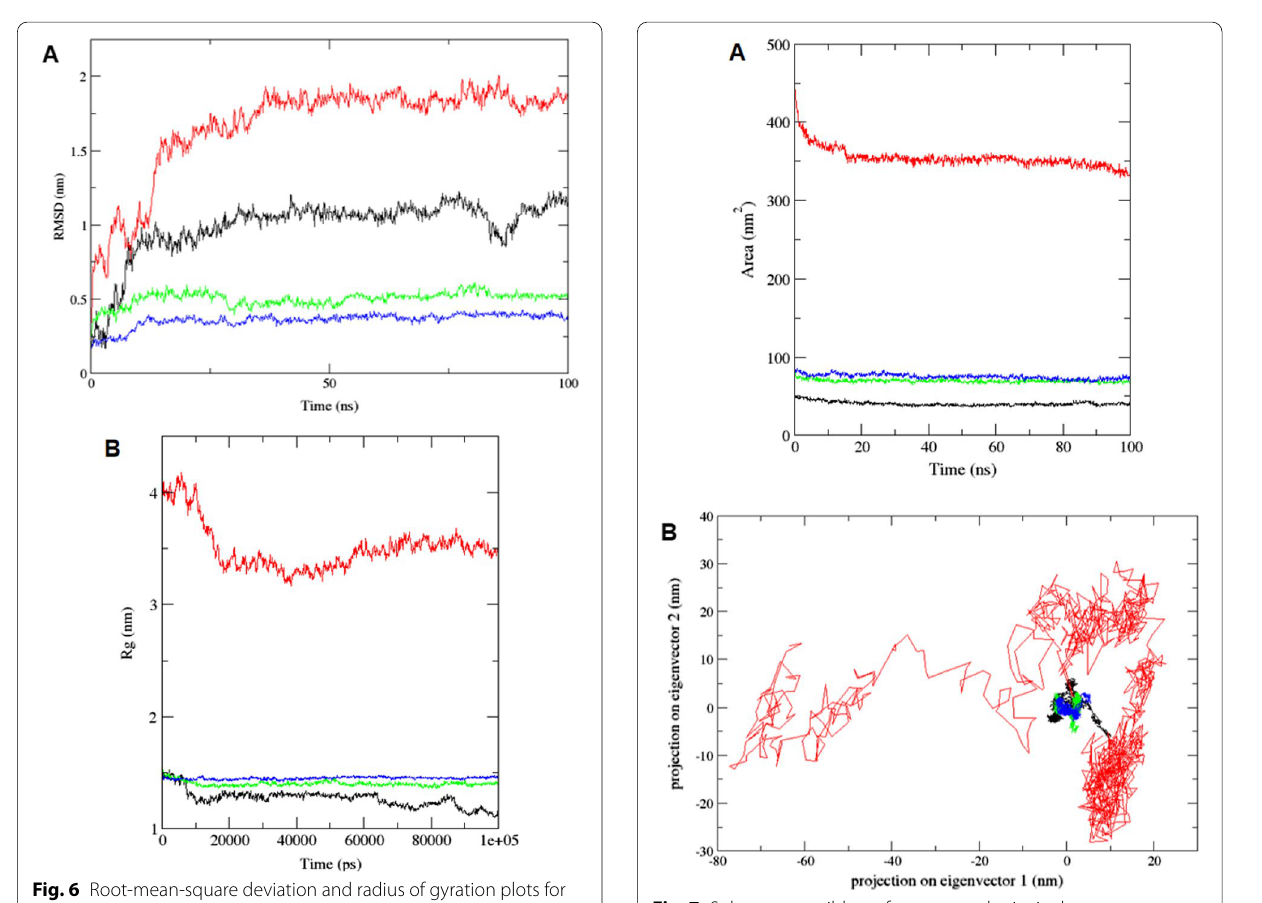
Fig. 7 Solvent-accessible surface area and principal component analysis plots for the individual components of the CENP-HIKM sub-complex. A shows the SASA plot of the sub-complex components, while ( B ) displays the PCA plot for each protein making up the sub-complex. Trajectories of the CENP-H, CENP-I, CENP-K and CENP-M are colored in black, red, green and blue,